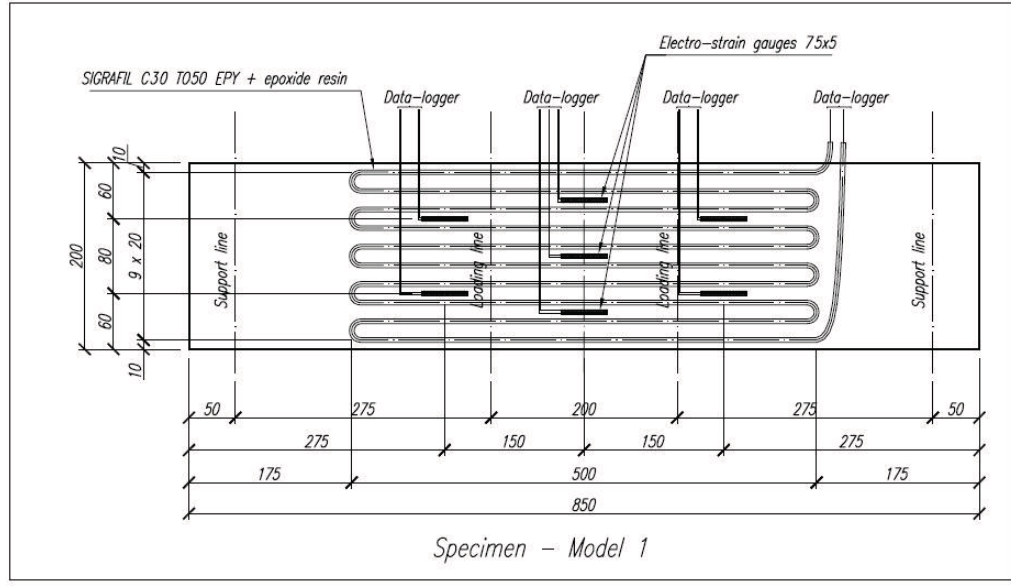
Figure 2. Scheme of specimens SP1 and SP2—strengthened with Continuous Carbon Fibers Epoxy Composite, with dimensions in mm.